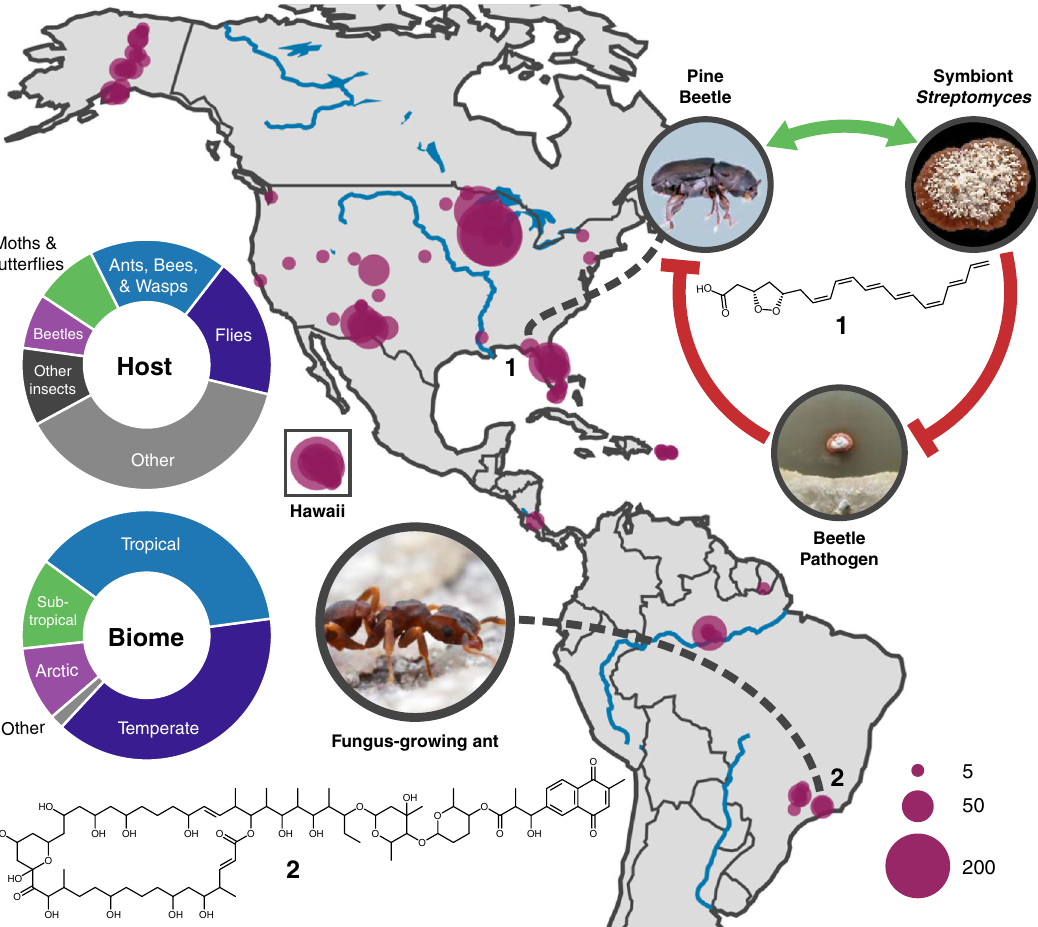
Fig. 1 Sampling strategy for Streptomyces from insect microbiomes. Streptomyces were isolated from a wide range of insects and geographies (1445 insects; 10,178 strains; dot size, insects sampled). Streptomyces production of the antifungal mycangimycin ( 1 ) in the Southern Pine Beetle system is shown at right. Cyphomycin ( 2 ) is a new antifungal described herein. Photo credits: southern pine beetle - Erich G. Vallery; fungus-growing ant – Alexander